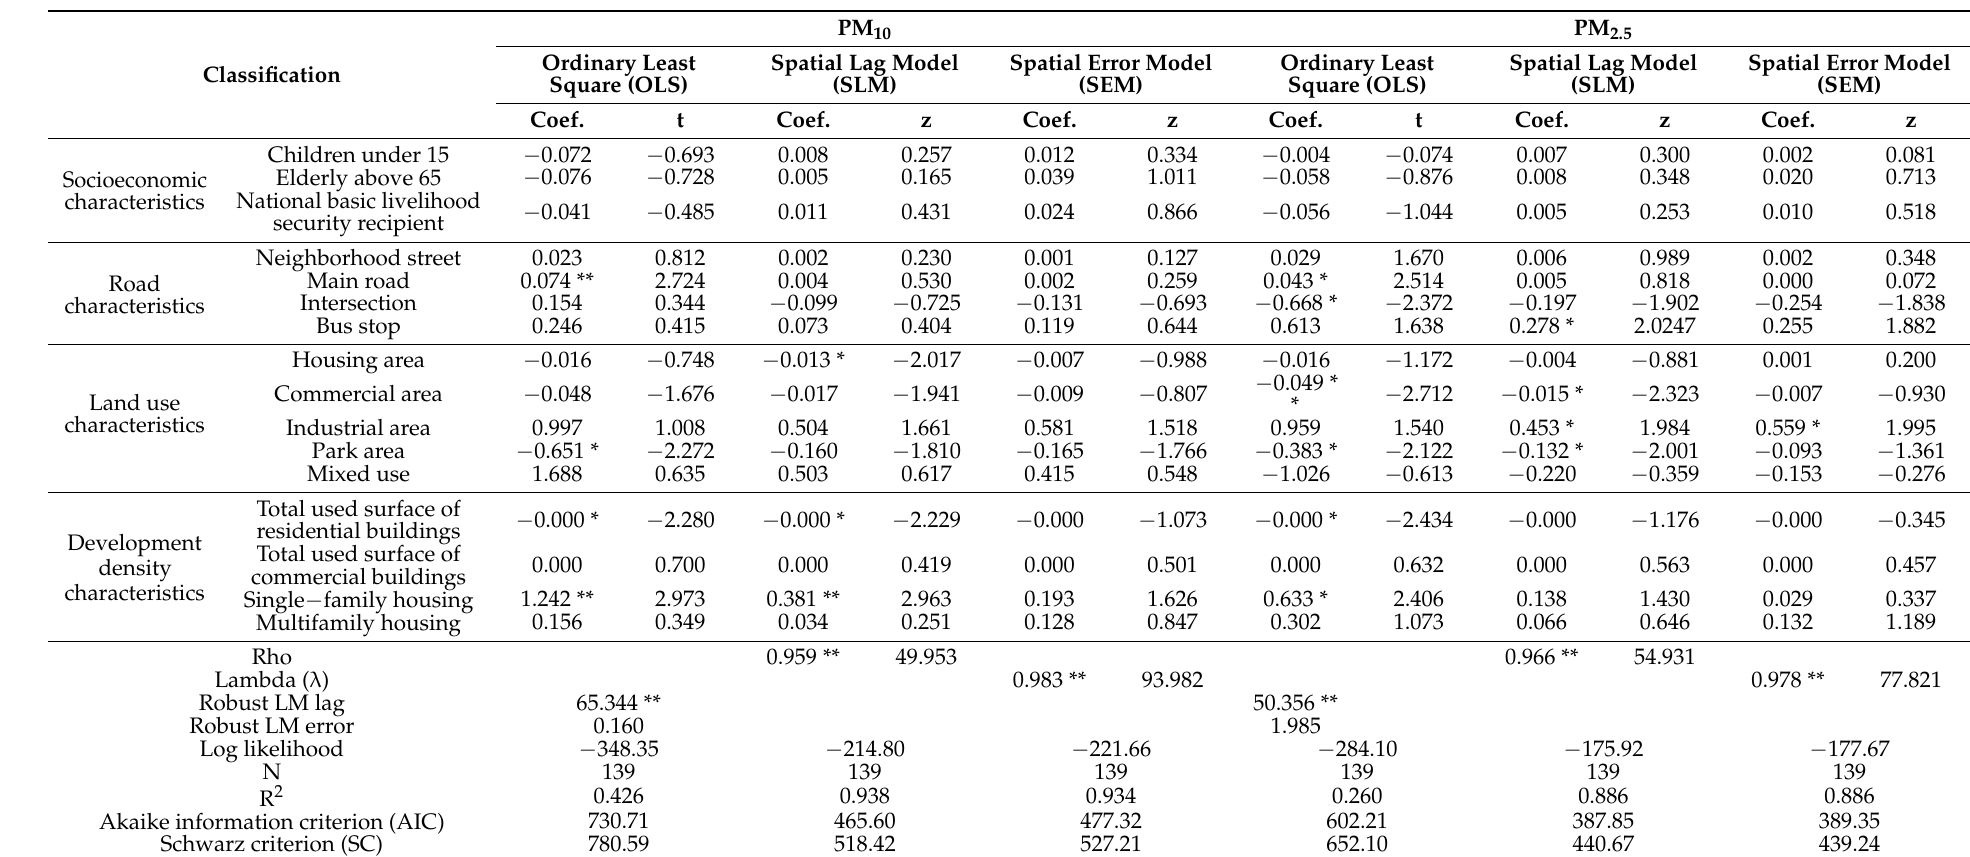
Table A1. Results of spatial regression